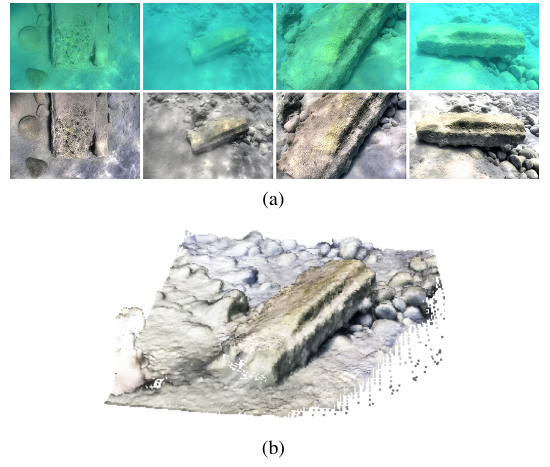
Figure 9: 3D model (b) obtained from a color corrected dataset of underwater images